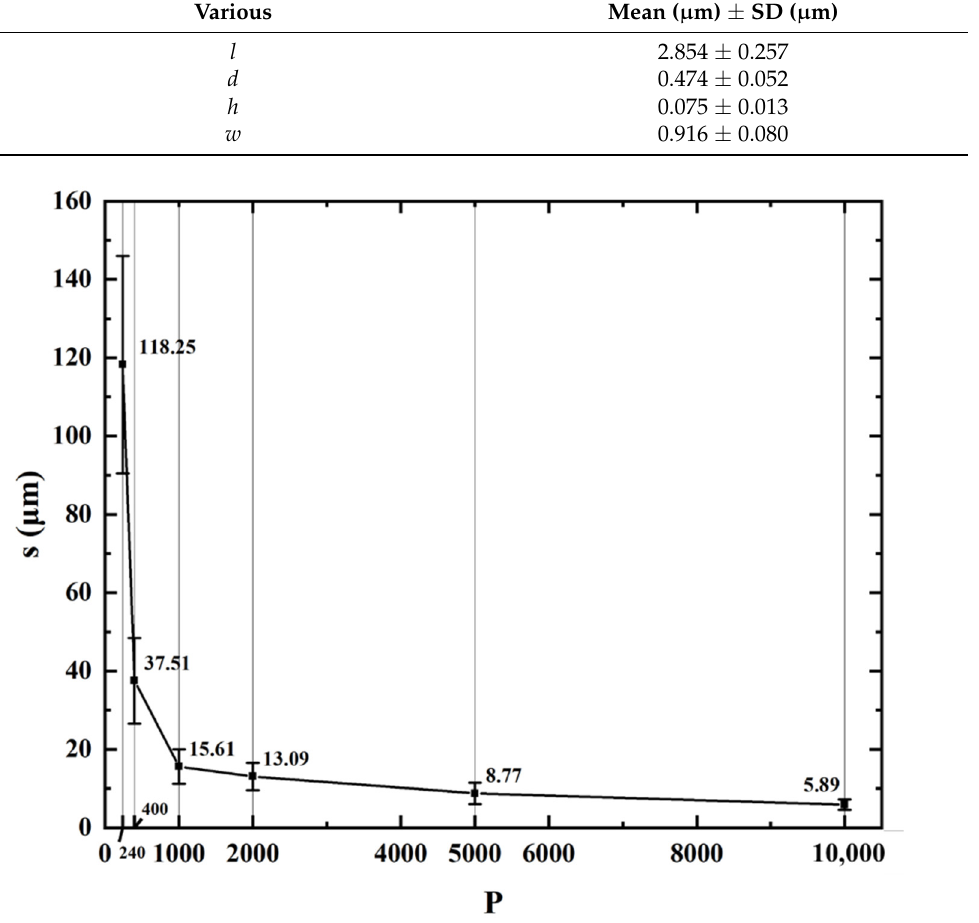
Figure 4. The size of sandpaper particles. Table 2. Summary of elastic modulus and hardness values for the ventral scale.